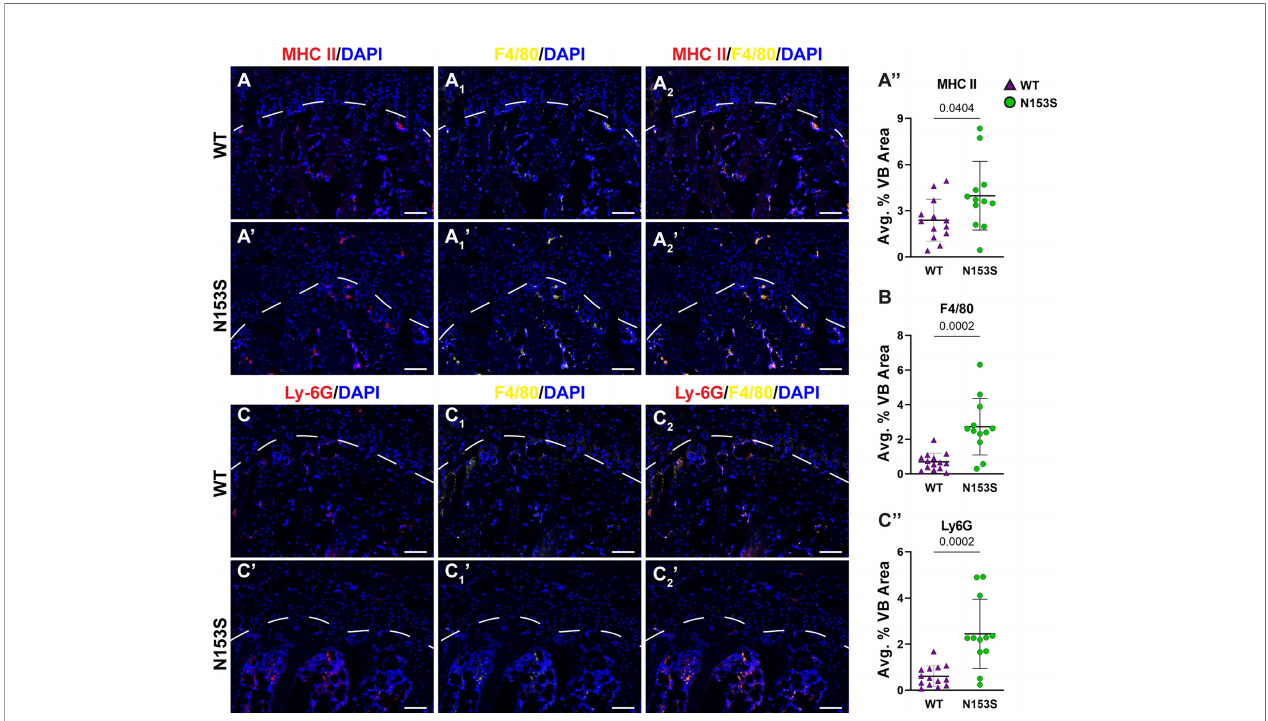
FIGURE 3 | N153S vertebrae show increases in macrophages and monocytes. Immunohistological staining conducted on 6-month-old WT and N153S vertebrae for (A, A ’ ) MHC II co-stained with (A 1 , A 1 ’ ) F4/80 and their (A 2 , A 2 ’ ) overlap, with each stain (A ” , B) individually quanti fi ed. Quantitative staining was also conducted for (C-C ” ) Ly-6G co-stained with F4/80. Images were taken at 10x (scale bar=100 m m). (n = 6-7 animals/genotype, 2 vertebrae/animal, 12-14 total vertebrae/genotype) Dotted lines demarcate different the boundary of the vertebral growth plate. Quantitative data represents the mean ± SD. Signi fi cance was determined using unpaired